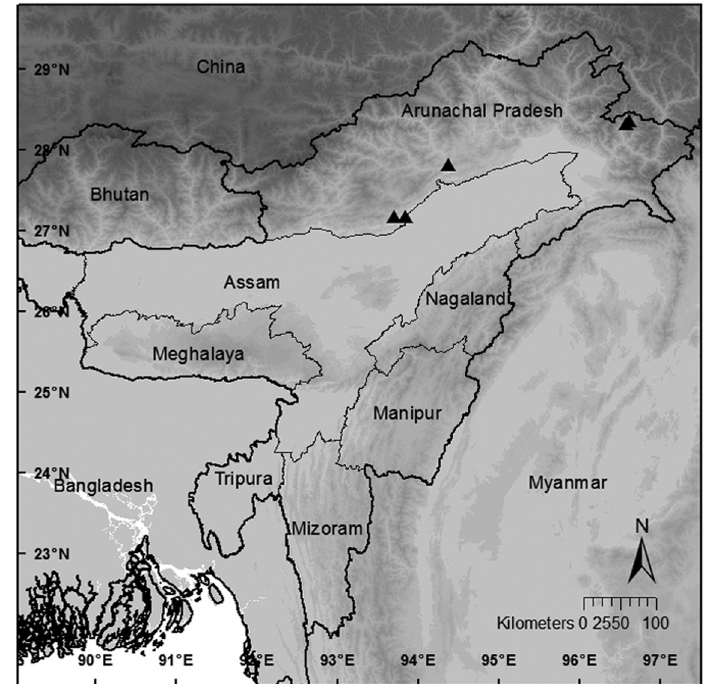
Fig. 6. Map showing the location of B. acetosella Craib